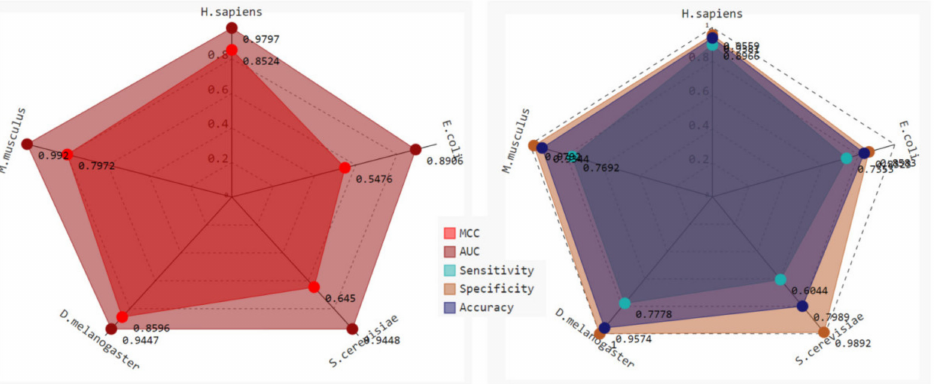
Figure 4. The radar map showing the performance of experiment II. The species on each corner served as the testing data, while the remaining data were used for training. Different colored radar maps indicate different metrics of performance.